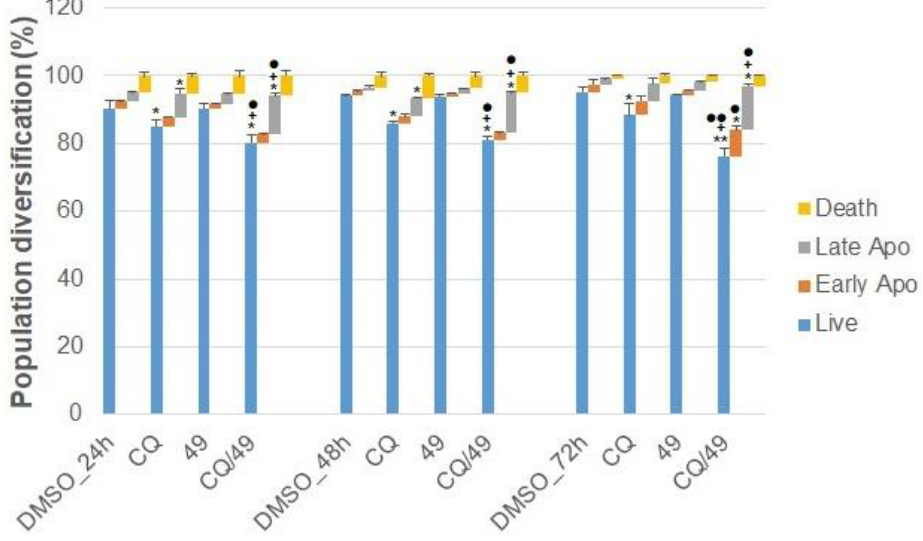
Figure 8. Effect of compound 49 alone or in combination with chloroquine (CQ) on the apoptosis of A549 cells after 24, 48 and 72 h incubation. The data show the mean ± SD values of three independent experiments. Statistical significance: * p < 0.05, ** p < 0.01 vs. DMSO; + p < 0.05 vs. CQ; ● p < 0.05, ●● p < 0.01 vs. 49.